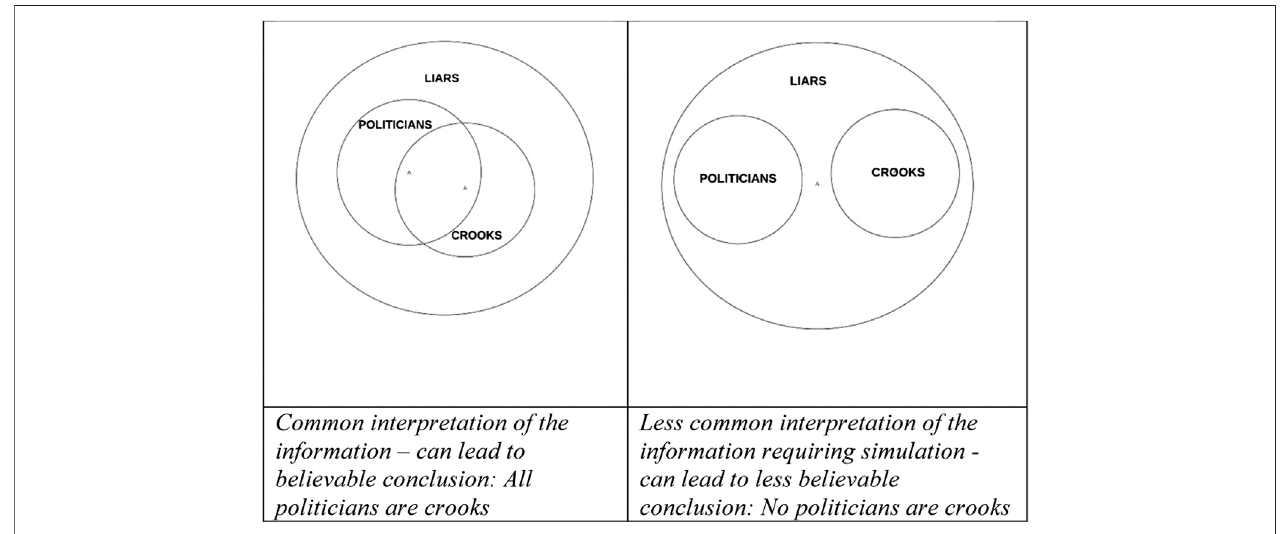
FIGURE 3 | Two types of information